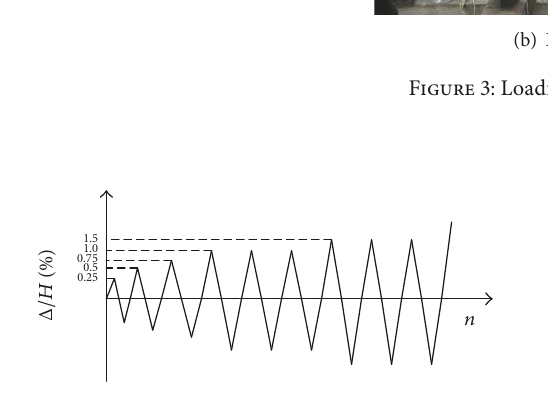
Figure 4: Cyclic loading